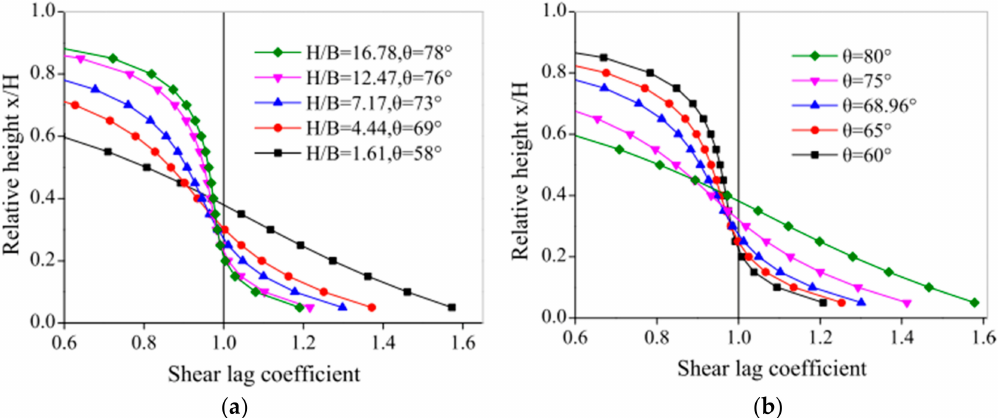
Figure 16. Shear-lag coe ffi cient in diagrids depending on the diagonal angle and building aspect ratio: ( a ) e ff ect of aspect ratio under optimal angle; ( b ) e ff ect of diagonal angle under fixed aspect ratio. Used with permission from Shi and Zhang